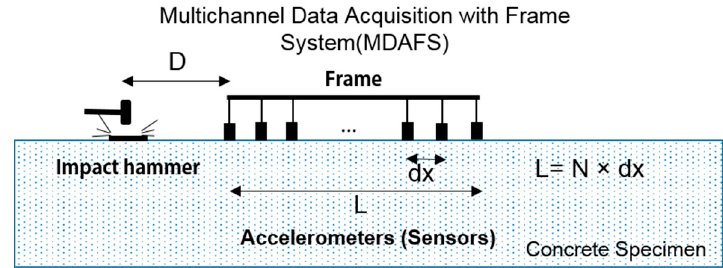
Figure 4. The scheme for an MASW test associated with MDAFS. D is near the offset; dx is the sensor spacing; and L is the offset range.